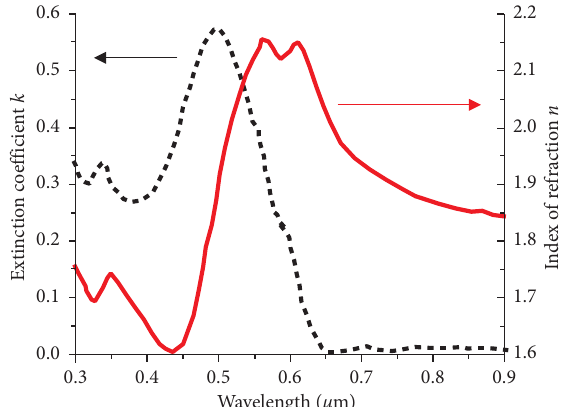
Figure 2: Optical constants of P3HT:PCBM with 1 :1 weight ratio, and index of refraction n and extinction coefficient k are real [10].